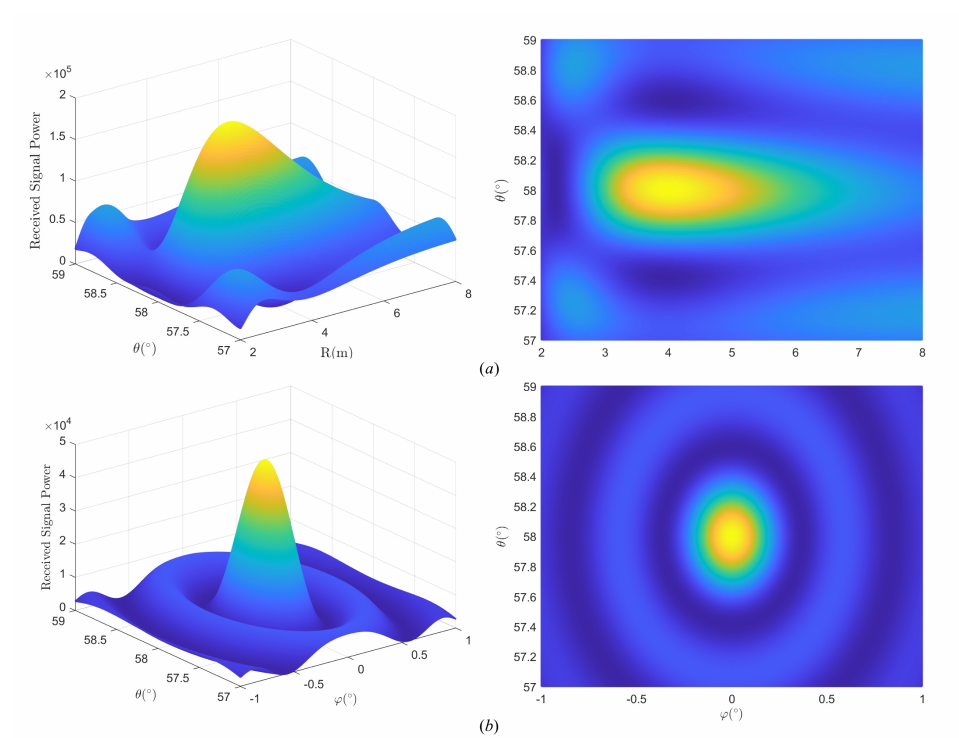
Figure 9. Beampattern in ( a ) R − θ domain. ( b ) ϕ − θ domain.